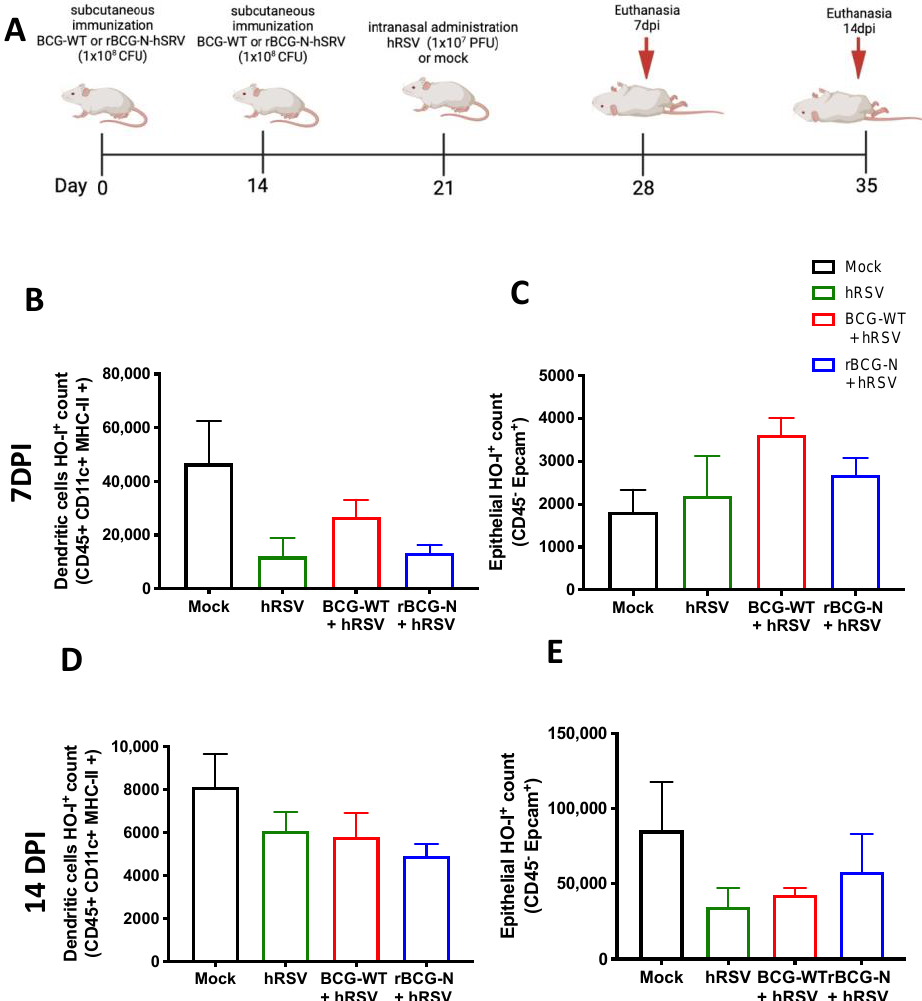
Figure 5. Detection of Heme Oxygenase (HO)-1 in cell populations during an immunization scheme with recombinant BCG expressing the nucleoprotein of human respiratory syncytial virus (rBCG- N-hRSV). Immunization scheme of BALB/c mice ( A ). Analysis by flow cytometry of dendritic cells (DC) ( B ) and epithelial cells ( C ) at 7 days post-challenge, and DCs ( D ) and epithelial cells ( E ) at 14 days post-challenge. Data are shown as means ± SEM of one independent experiment with three animals per group. One-way ANOVA was performed with a post-hoc Tukey test.